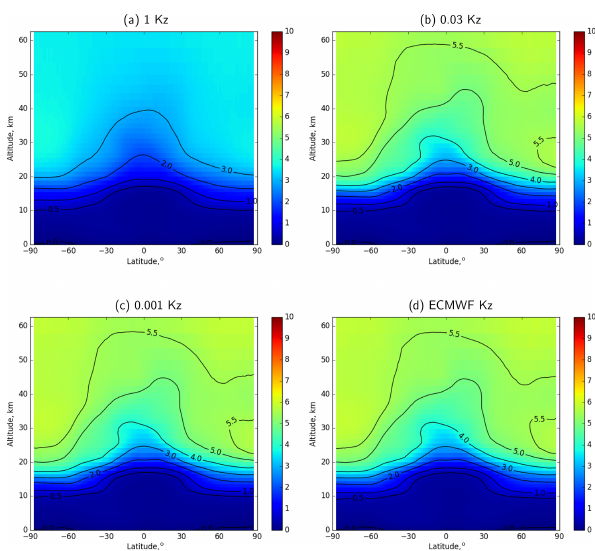
Figure 10. The zonal-mean spatial distribution of the ideal-age AoA for 2011 calculated for different eddy-diffusivity